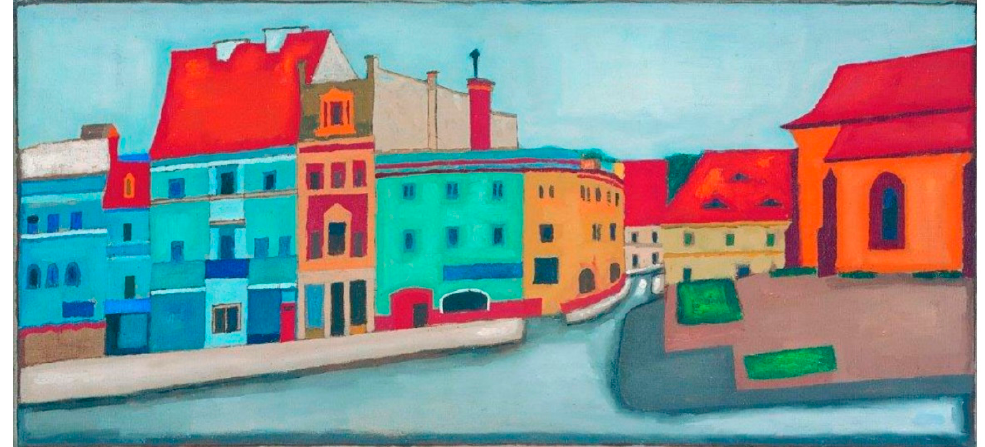
Figure 8. Jerzy Nowosielski: City landscape, 1956. Photography by M. Gardulski/Galeria Starmach. Reproduced with permission.